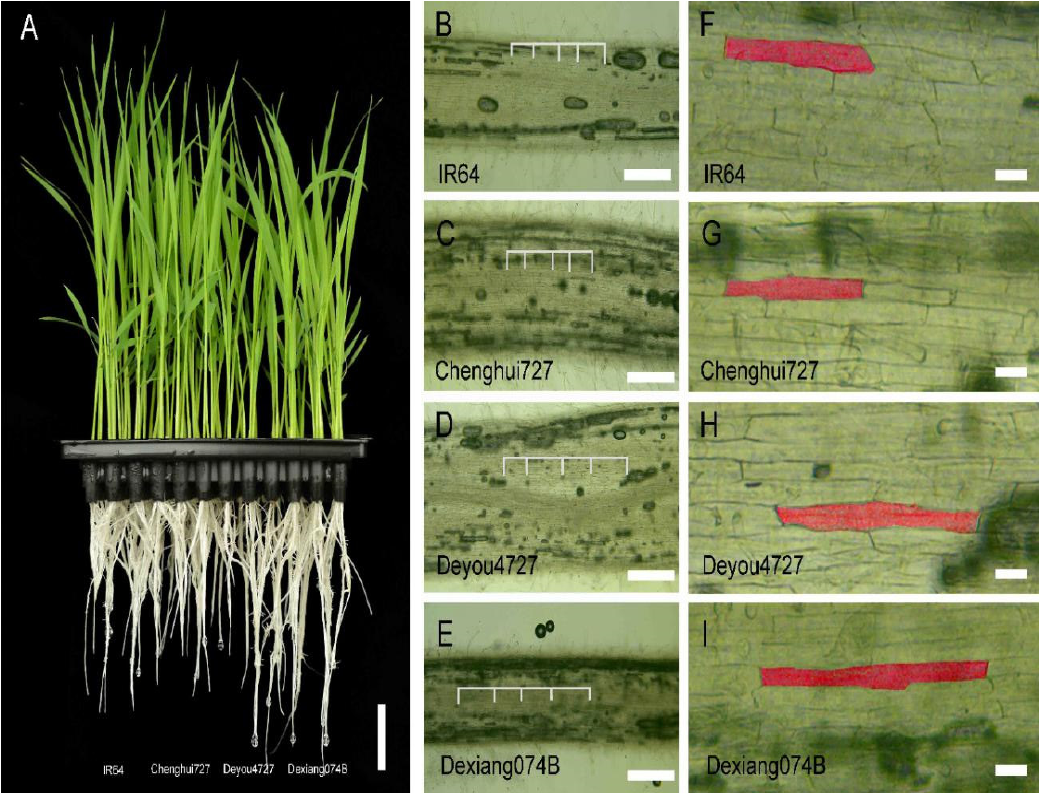
Figure 3. The root morphology of IR64, Deyou4727, and its parents in two dimensions ( A ) and three dimensions ( B ).